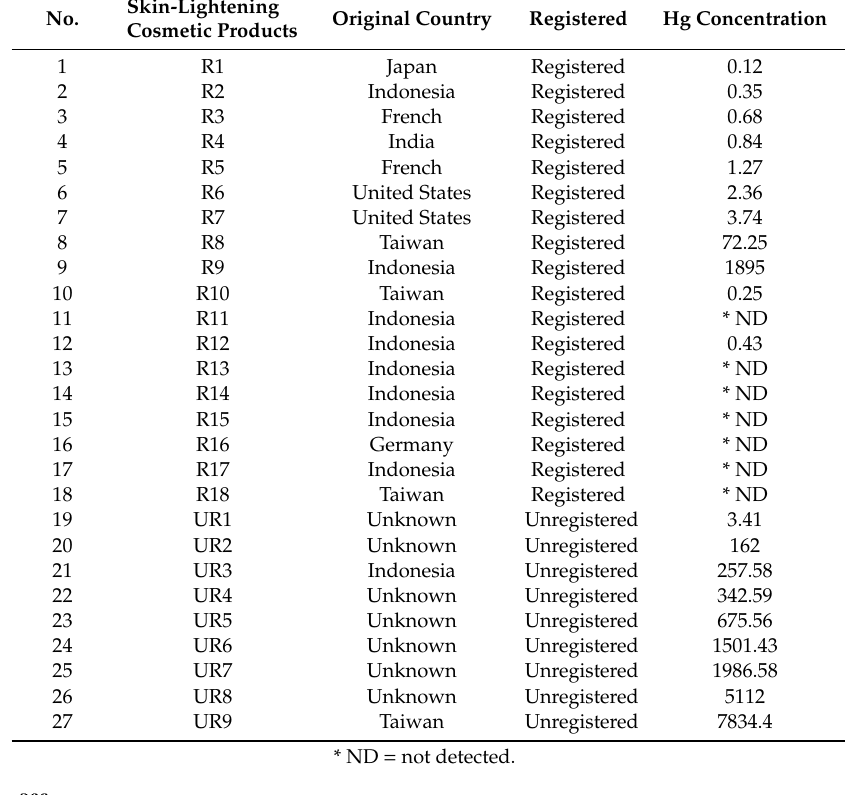
Table 4. Mercury content of skin-lightening cosmetics.